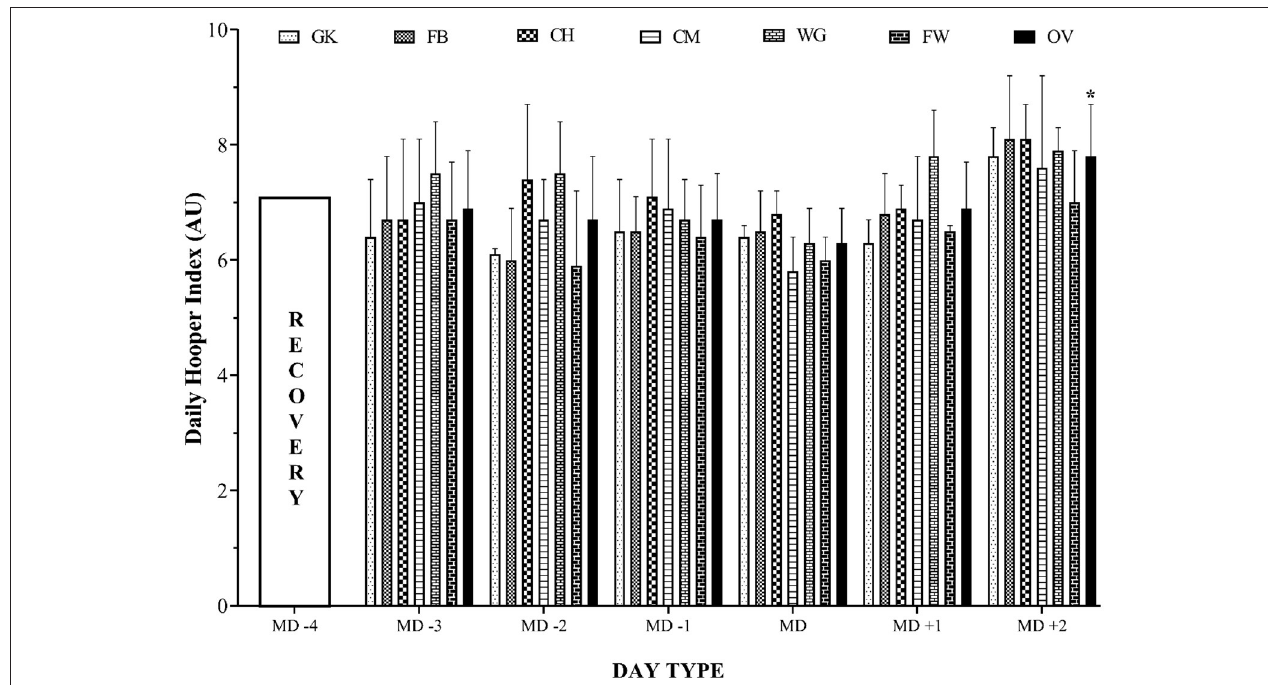
FIGURE 2 | Daily pattern and comparisons between every weekday and the match day in the Hooper questionnaire during a common competition microcycle for the overall team and by playing position. GK, goalkeeper; FB, fullback; CH, center half; CM, center midfielder; WG, winger; FW, forward. *Significant differences for P ≤ 0.05 compared to MD, match